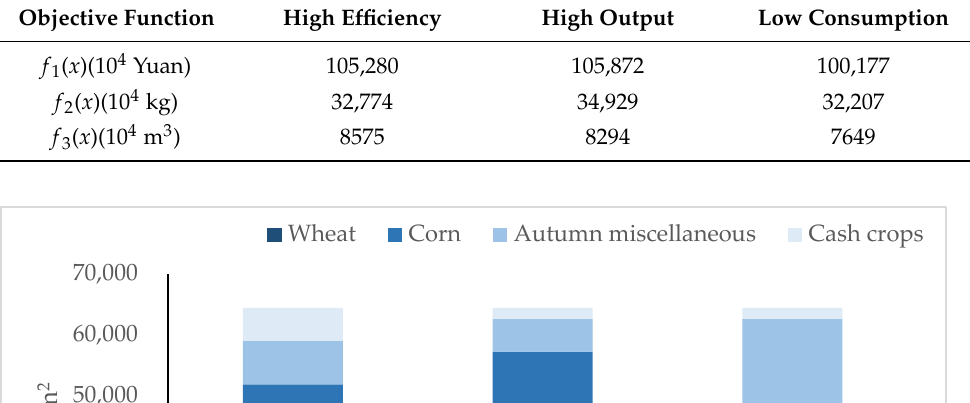
Table 2. Single objective optimisation value of CPSO model.